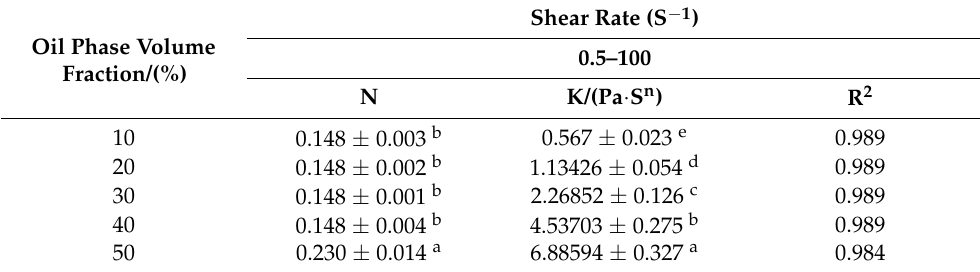
Table 2. Power law equations and parameters of the Pickering emulsion prepared at various oil phase volume fraction.